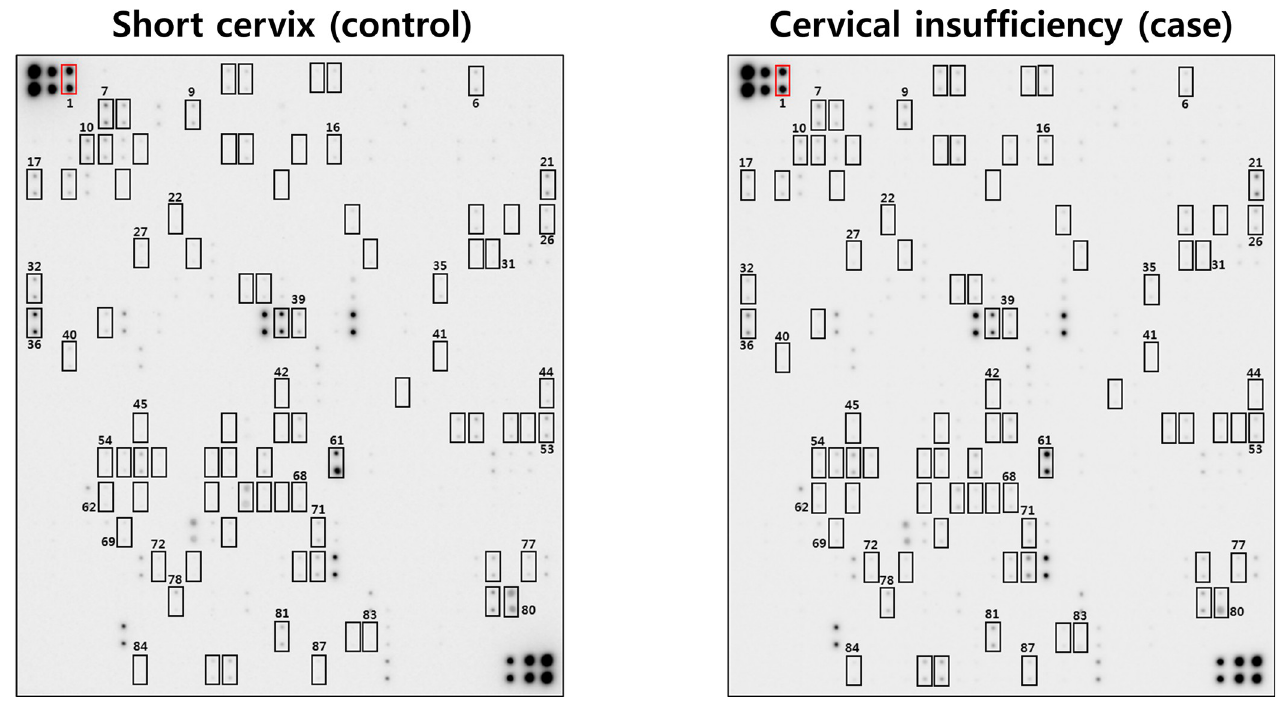
Fig 1. Expression profile of 507 proteins in the amniotic fluid (AF) of patients with cervical insufficiency (CI, case subjects) versus short cervix (SCX, control subjects). Pooled AF samples from each group (20 samples per group, matched for gestational age) were assayed using a human antibody array kit. Fold change cutoff values of � 1.3 or � 0.77 for upregulated or downregulated proteins, respectively, revealed 86 differentially expressed proteins (indicated in rectangles) in AF samples from patients with CI relative to SCX controls. Number 1 indicates the positive